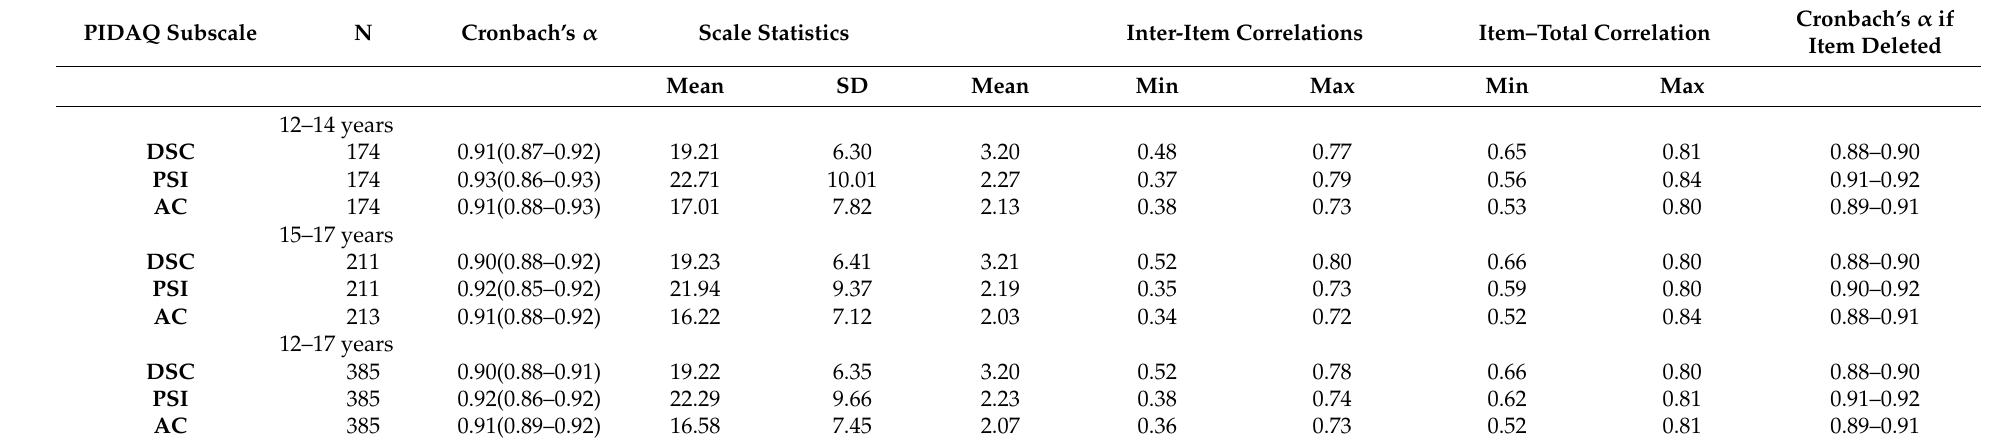
Table 3. Reliability statistics of the PIDAQ(A) subscales.